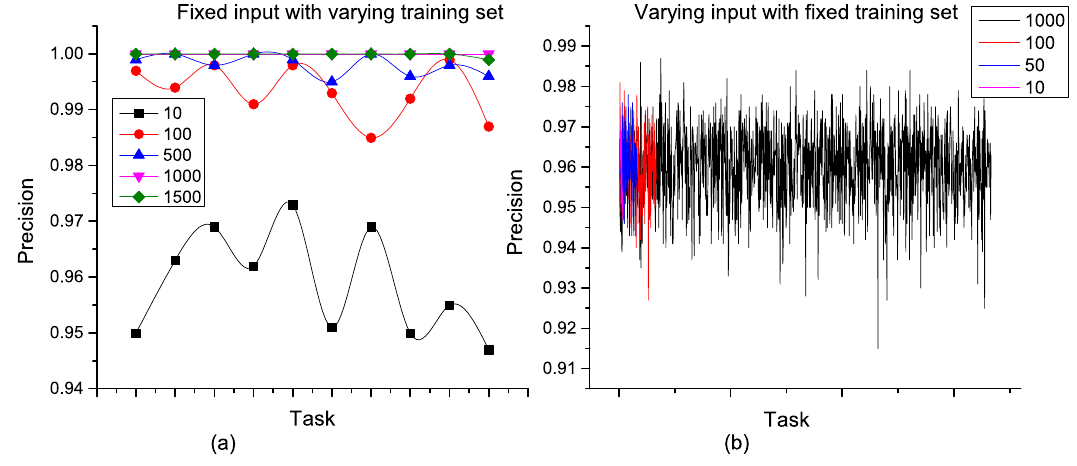
Figure 8. Single-stage task decomposition with single-stage training sets. ( a ) Fixed input with varying training set; ( b ) Varying input with fixed training